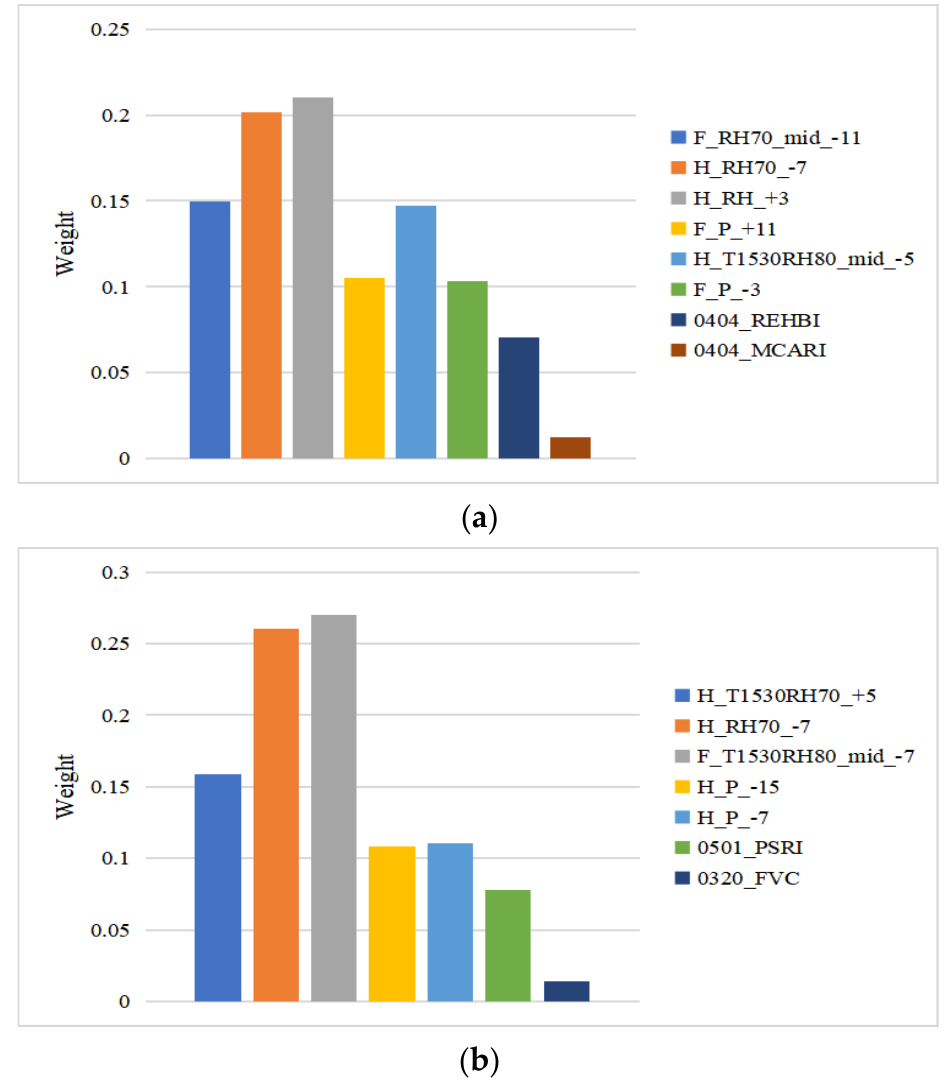
Figure 3. Weighting results of factors on 29 April 2021 ( a ) and 10 May 2021 ( b ).